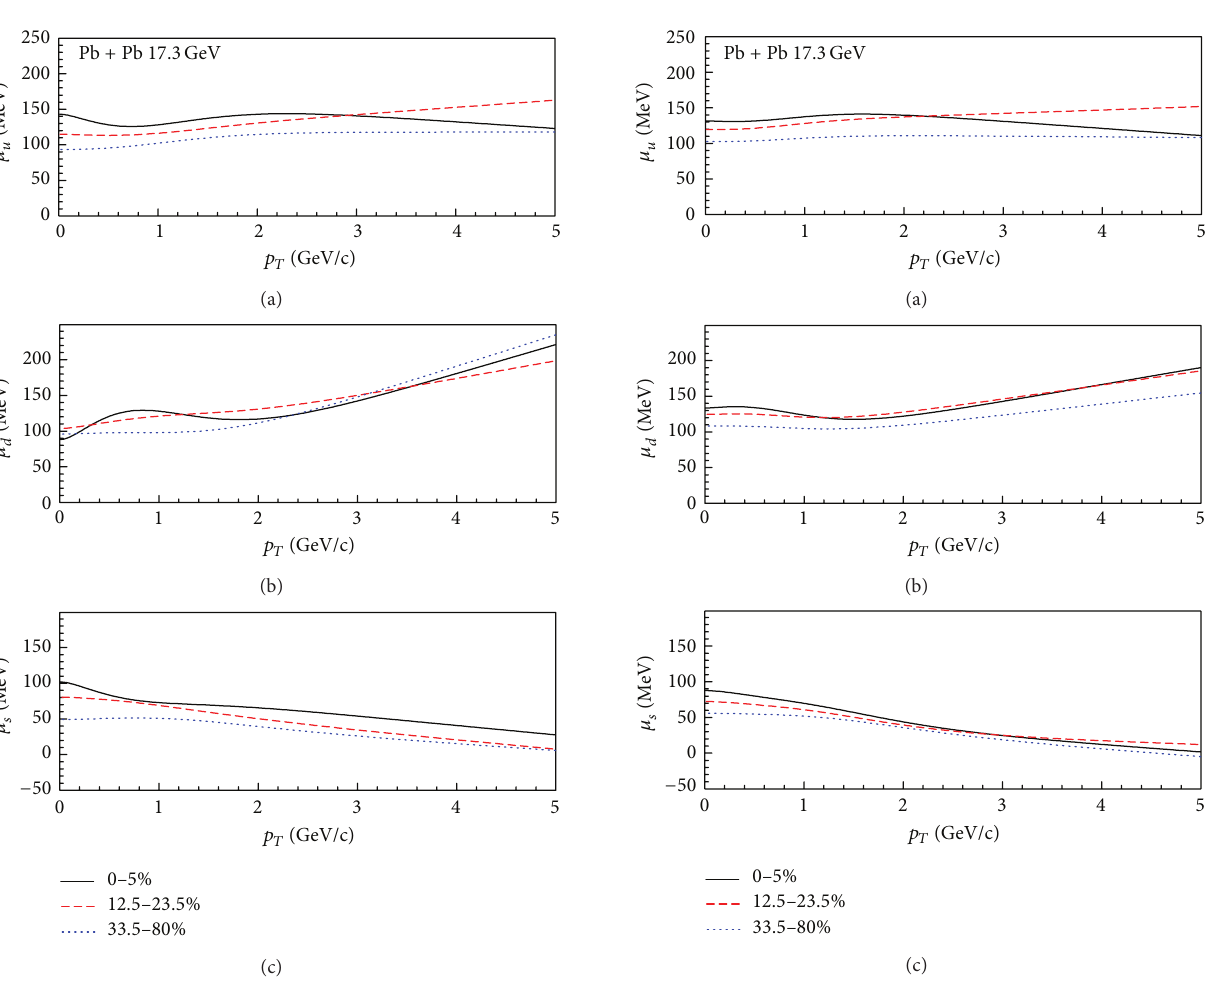
Figure 2: According to the solid curves in Figure 1, the calculated chemicalpotentialsof(a)up,(b)down,and(c)strangequarksinPb- Pb collisions at 17.3 GeV are displayed, where the solid, dashed, and dotted curves correspond to the centralities of 0–5%, 12.5–23.5%, and 33.5–80%, respectively.